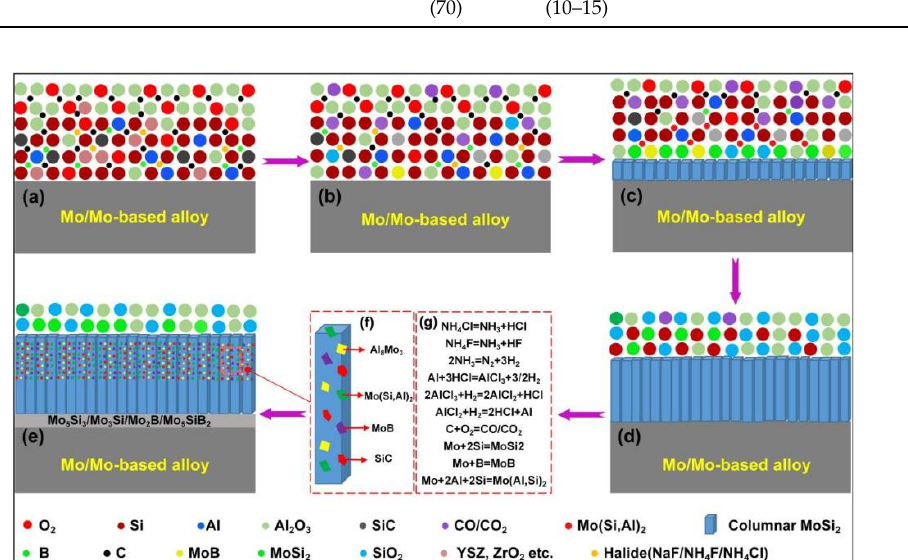
Figure 2. Growth mechanism diagram of HAPC coating on molybdenum and its alloys. ( a ) pre- sedimentation, ( b ) Oxygen consumption in the system,( c ) The initial phase of the reaction,( d ) The growth stage of the coating,( e ) The final structure of the coating,( f ) Amplification of individual coating grains, ( g ) The reactions involved in the above process.